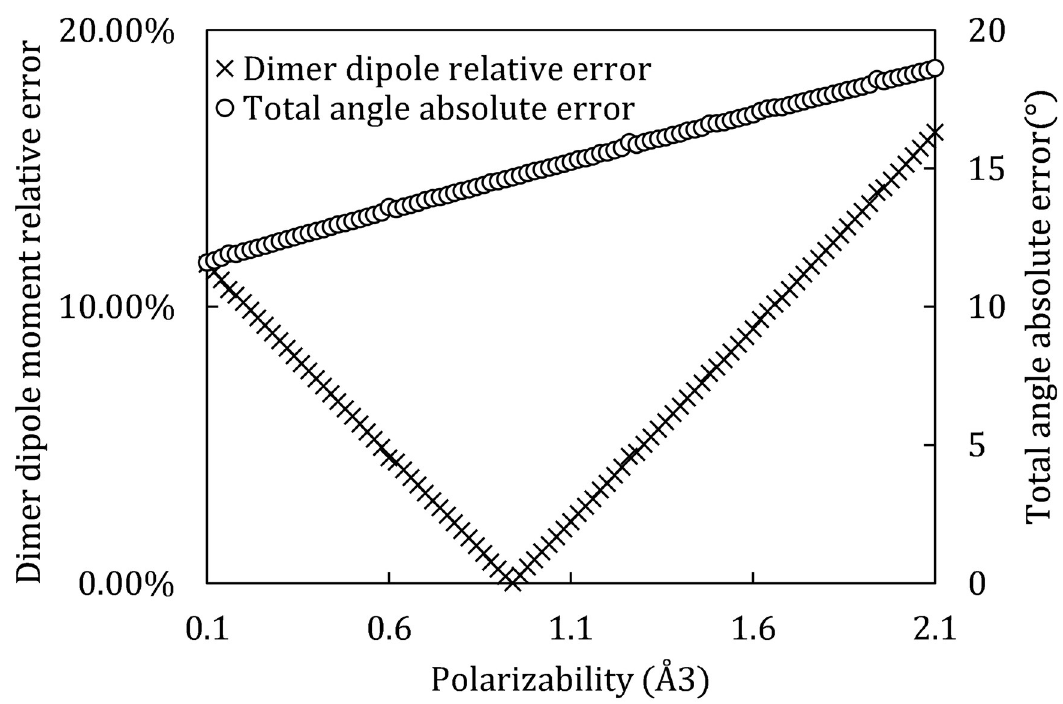
Fig 7. Dimer total dipole moment and total angle error of the limited optimal 3-point polarizable model. With the water monomer dipole fixed at 1.86D, we test different 3-point polarizable models by varying the polarizability from 0.10 Å 3 to 2.10 Å 3 . The blue diamond symbols represent the total dipole errors and the orange triangle symbols show the total angle errors, where both are compared with the ab initio reference [38, 39].